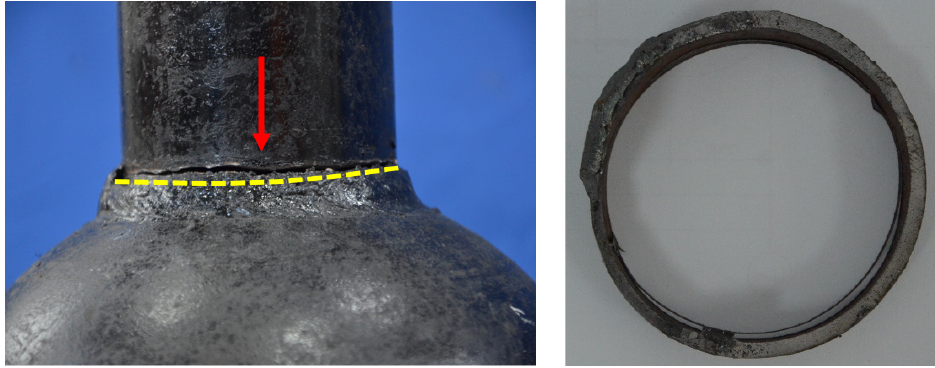
Figure 12. Failure mode 1.